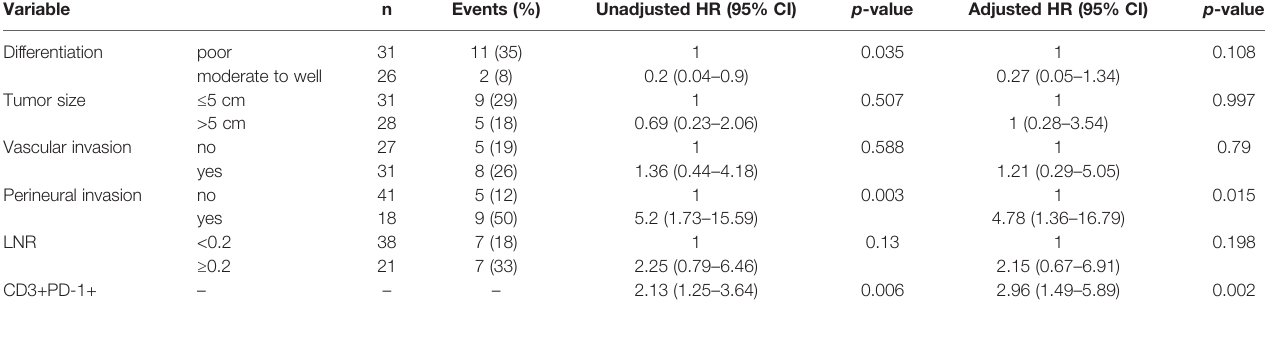
TABLE 4 | Multivariate analysis of disease-free survival in advanced-stage dMMR CRCs. Variable